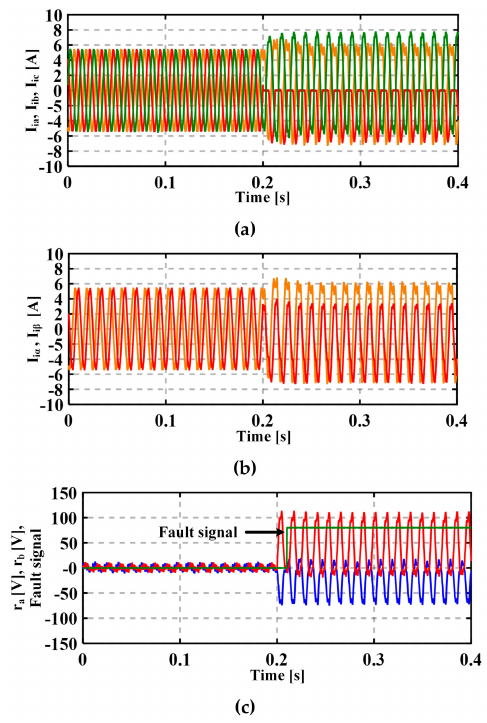
Figure 10. Experimental results: Open-switch fault on Q 3 at 0.2 s. ( a ) Filter currents of the three phases I ia (yellow), I ib (red), I ic (green); ( b ) filter currents in the stationary reference frame i i α (yellow), i i β (red); ( c ) residual errors r α (blue) r β (red), fault signal (green).